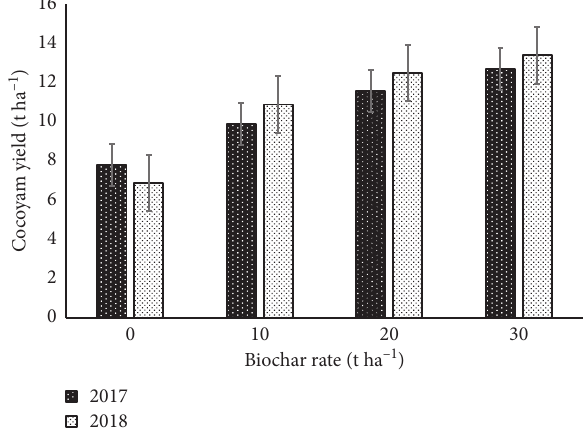
Figure 1: Effects of different rates of biochar on cocoyam yield in 2017 and 2018; vertical bars show standard